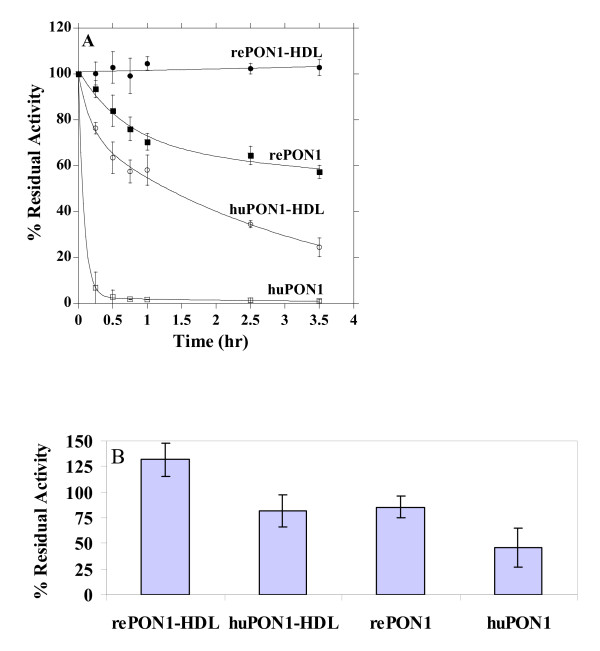
Inactivation of the recombinant and human PON1, and PON1-HDL complexes in the presence of calcium chelator (A) or in buffer (B). Data represents mean ± SD of at least 3 independent experiments. A. Inactivation kinetics of rePON1, rePON1-HDL, huPON1, and huPON1-HDL (huHDL) by EDTA (4 mM) and β-mercaptoethanol (8 mM) at 37°C. Residual activity at various time points was determined by initial rates of phenyl acetate hydrolysis and plotted as percent of the activity at time zero. Data were fitted to a single exponential for rePON1-HDL, and to double-exponentials for the remaining samples [35]. B. Inactivation of rePON1, rePON1-HDL, huPON1, and huPON1-HDL (huHDL), in PBS buffer with 1 mM CaCl2. Residual PON1 activity after 24 hrs incubation at 37°C is presented as percentage of the initial activity.